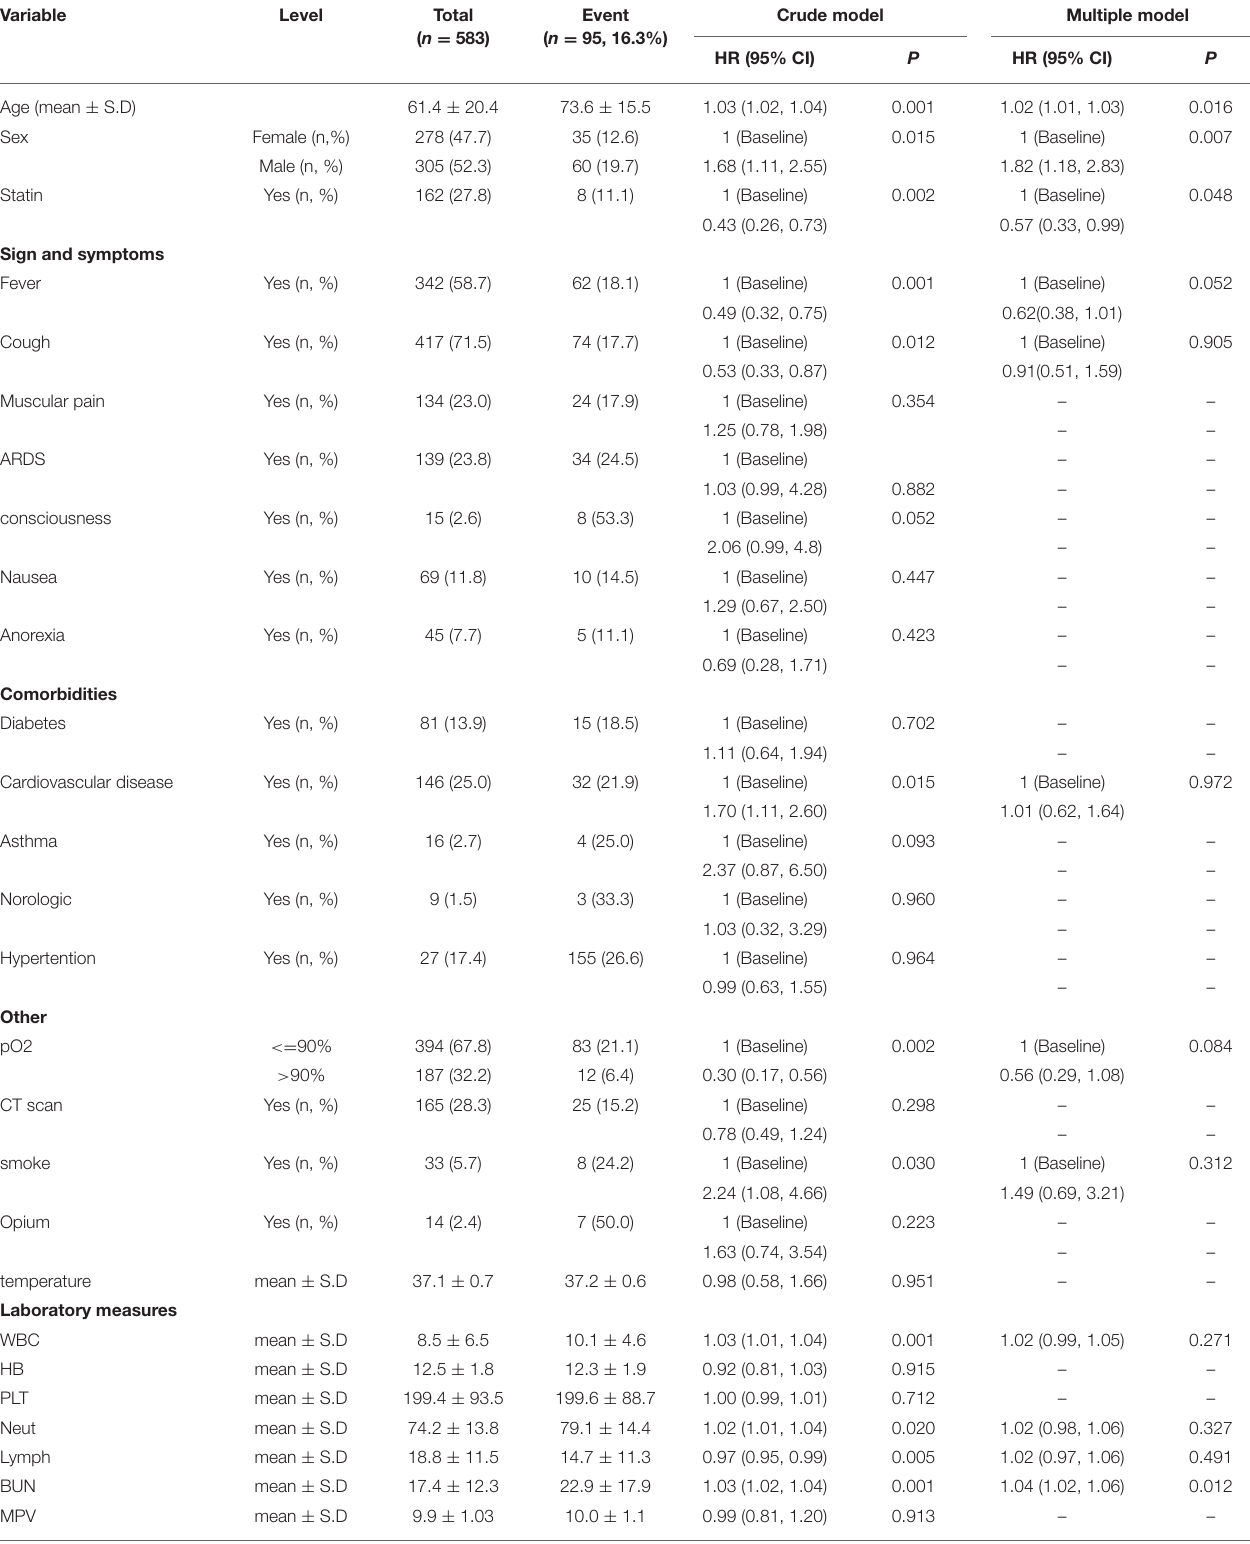
TABLE 3 | Data analysis using the crude and multiple Cox regression models for the composite outcome comprising mortality, ICU admission and intubation.